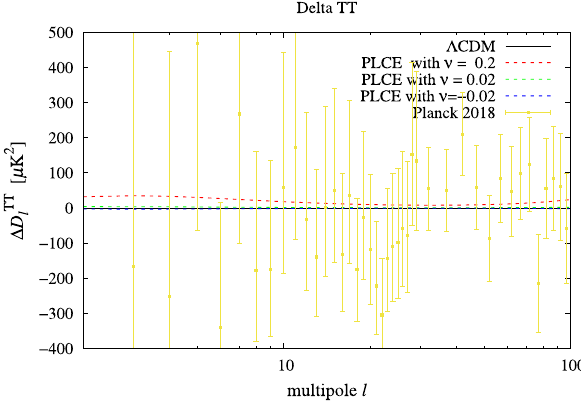
Fig. 3 The change (cid:9) D TT (cid:10) of the TT mode of CMB power spectra between PLCE and (cid:2) CDM, where the legend is the same as Fig. 1